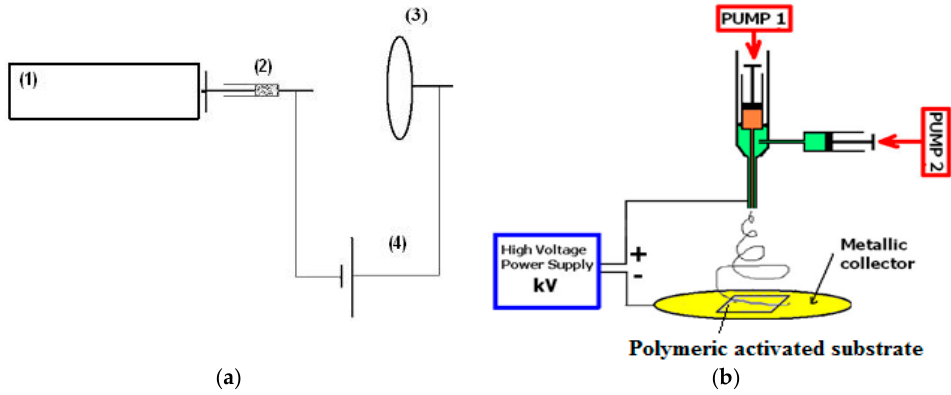
Figure 4. Representative experimental set-up of the uniaxial ( a ): (1) pump; (2) syringe; (3) collector; (4) high direct voltage (0 to 30 kV) power supply; or coaxial ( b ) electrospinning device used for immobilization of vegetable oil into chitosan and bioactive layer deposition onto polymeric activated substrate adapted from [146]; Vasile et al. (2016).